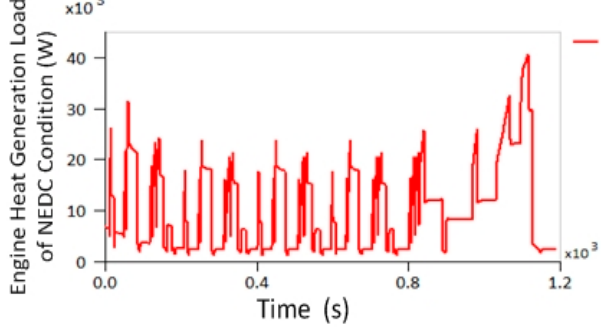
Energies 2019 , 12 , x FOR PEER REVIEW Figure 8. Engine thermal load under the test conditions. Figure 8. Engine thermal load under the test conditions. Figure 8. Engine thermal load under the test conditions.